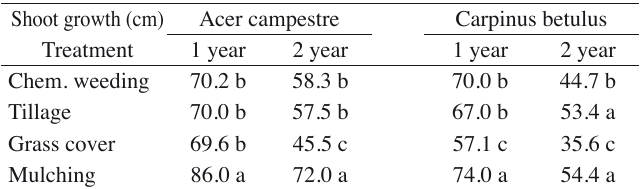
2 - Effect of soil management technique on shoot extension